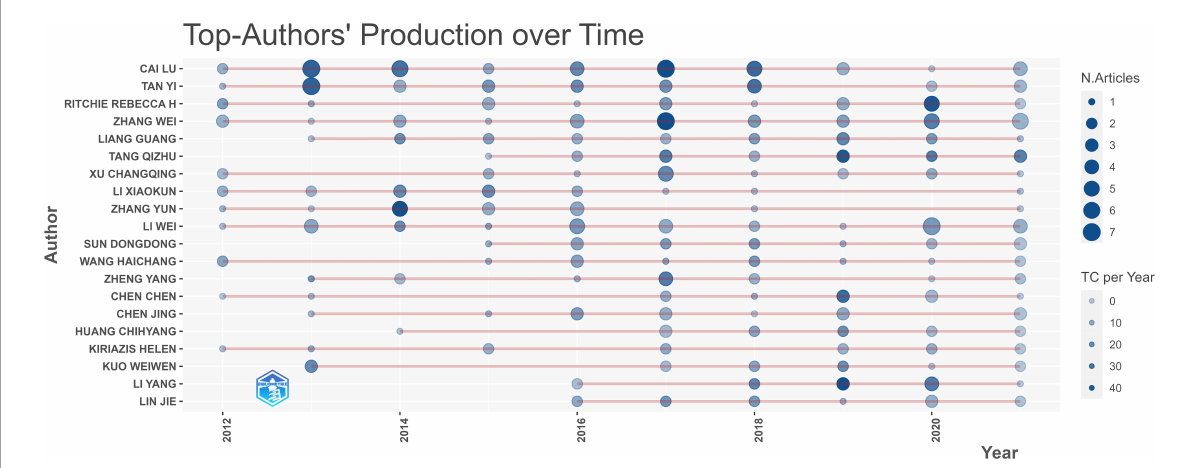
FIGURE5 Publications and citations per year of the top 20 most prolific authors in the field of DCM research in the past decade.